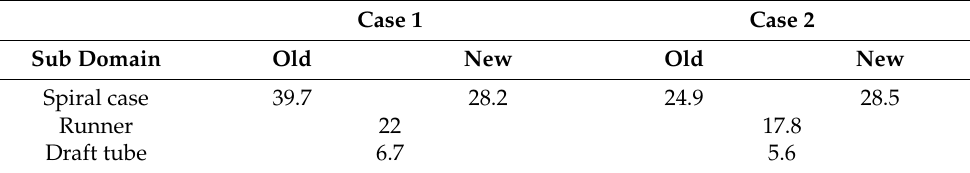
Table 6. Nodes (10 6 ) in meshes used for case 1 and 2 full turbine simulations.